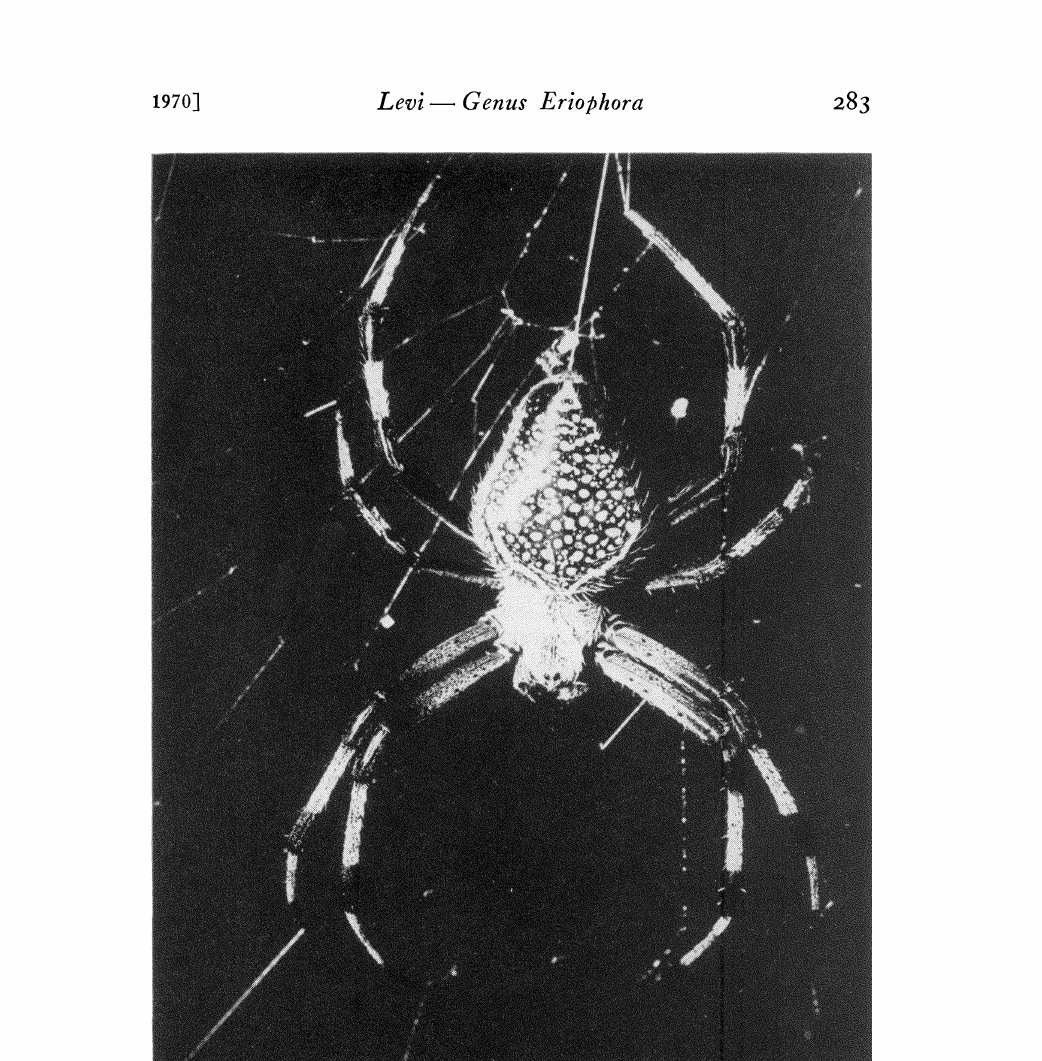
Fig. lb. Eriophora nephiloides. Photograph taken at Barro Colorado Island, Panama Canal Zone by Dr. M. H.